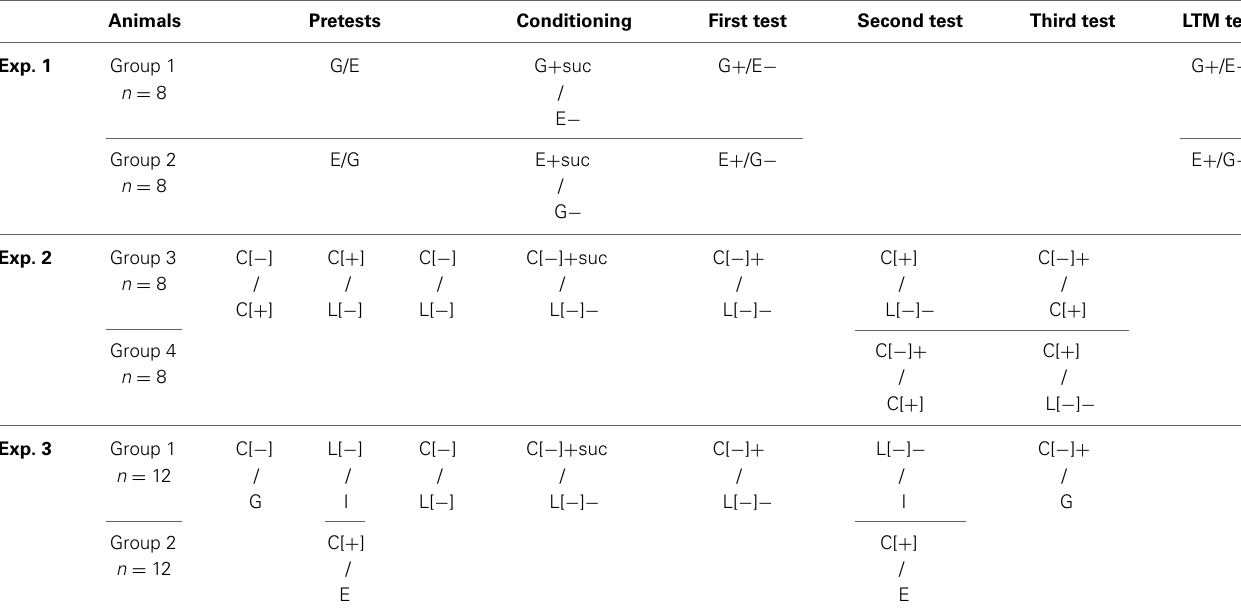
Table 1 | Summary of